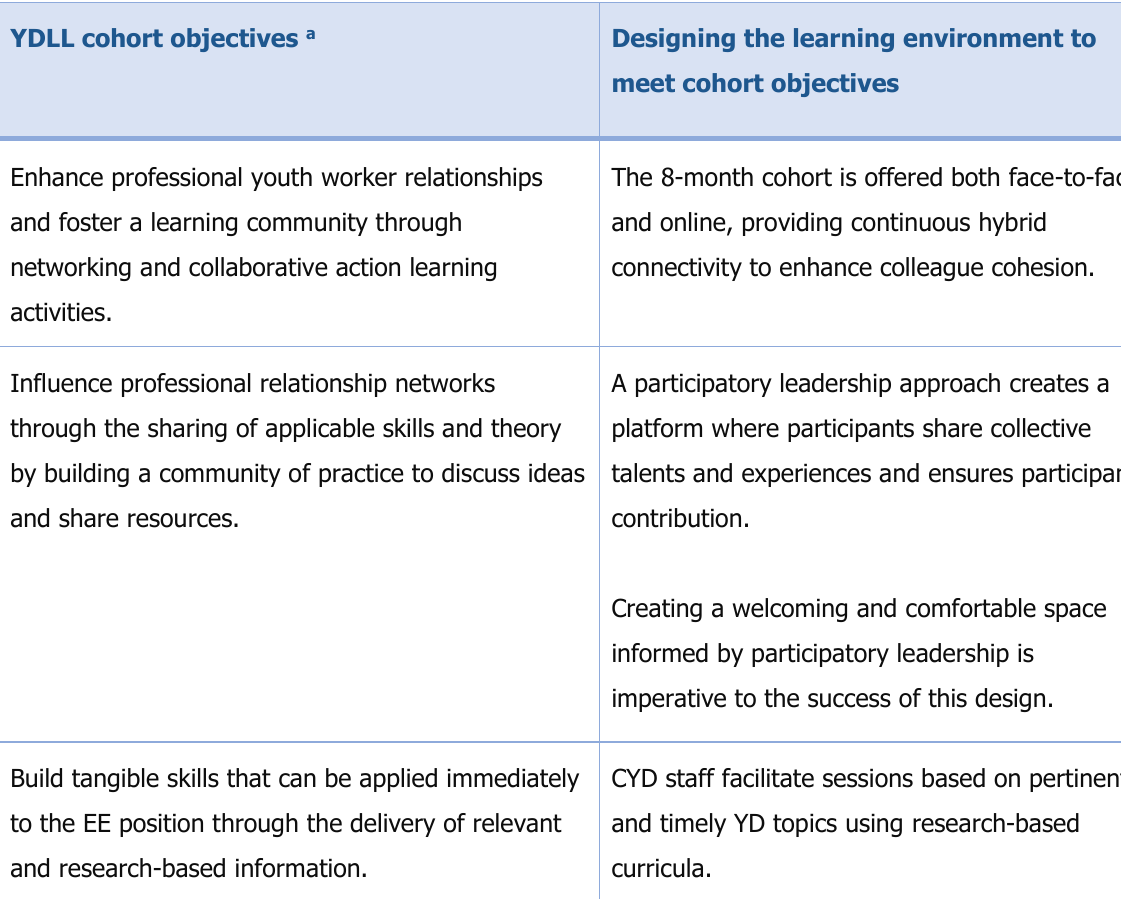
Table 1. Overview of YDLL Objectives and Cohort Design YDLL cohort objectives